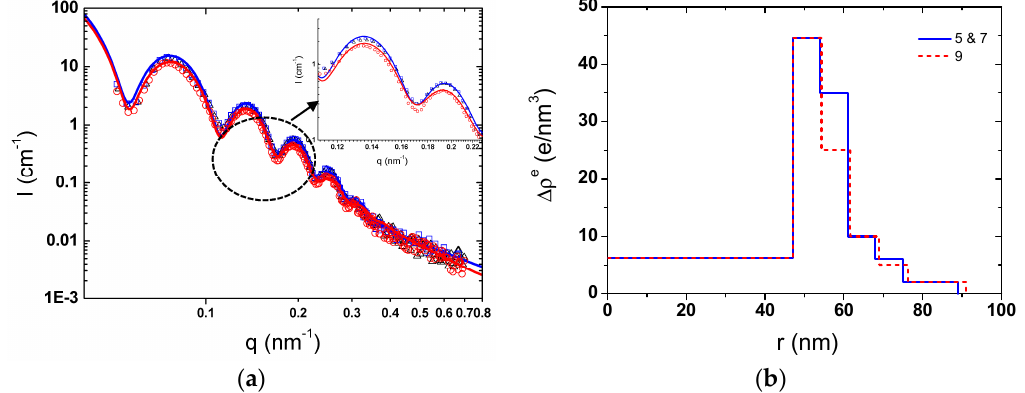
Figure 7. ( a ) Scattering intensity curves of PAA-PAH double-layer modified SPBs at pH 5 ( ∆ , black), pH 7 ( □ , blue), and pH 9 ( ○ , red). The solid lines are the corresponding fitting curves; the inset is the enlarged view of scattering curves (0.1 nm − 1 < q < 0.23 nm − 1 ); ( b ) The radial profile of excess electron density of PAA-PAH at different pH (C NaCl = 10 mM).